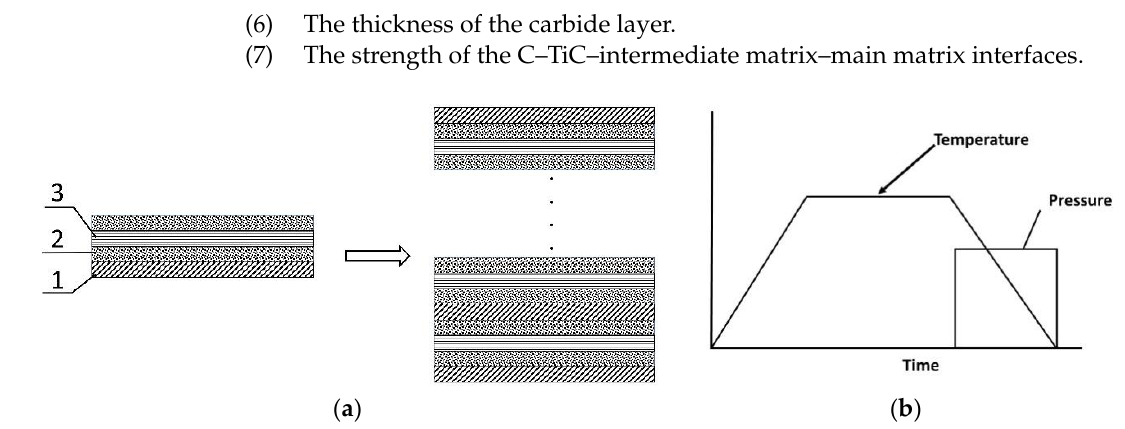
Figure 18. ( a ) Schematic of the method of producing composites.1: Main matrix, 2: Precursor of the intermediate matrix, 3: Fibre layer. ( b ) Schematic of the technological regime.